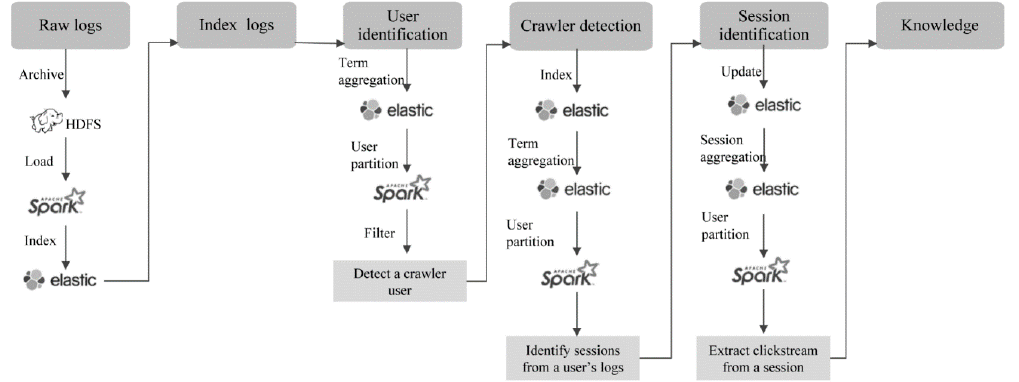
Figure 5. Information flow of the log-mining framework.